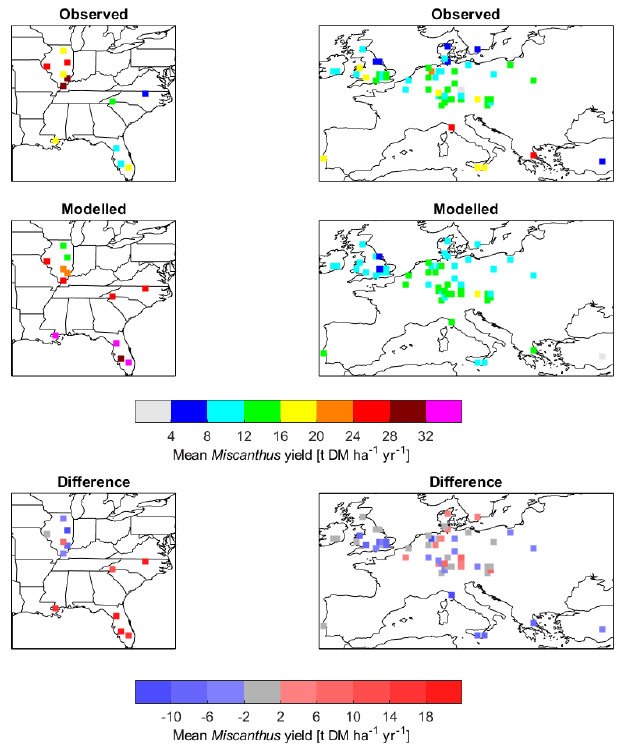
Figure 4. Comparison of modelled Miscanthus yields against ob- servations from Li et al.